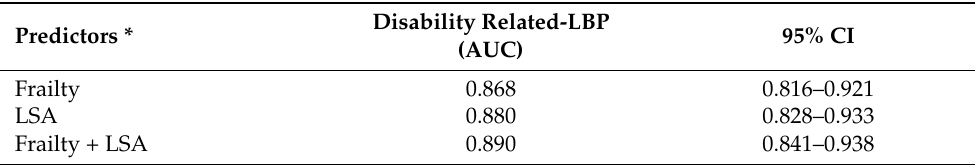
Table 4. The estimate of predictive power of frailty and life-space mobility on disability related-LBP among 165 older adults with LBP.